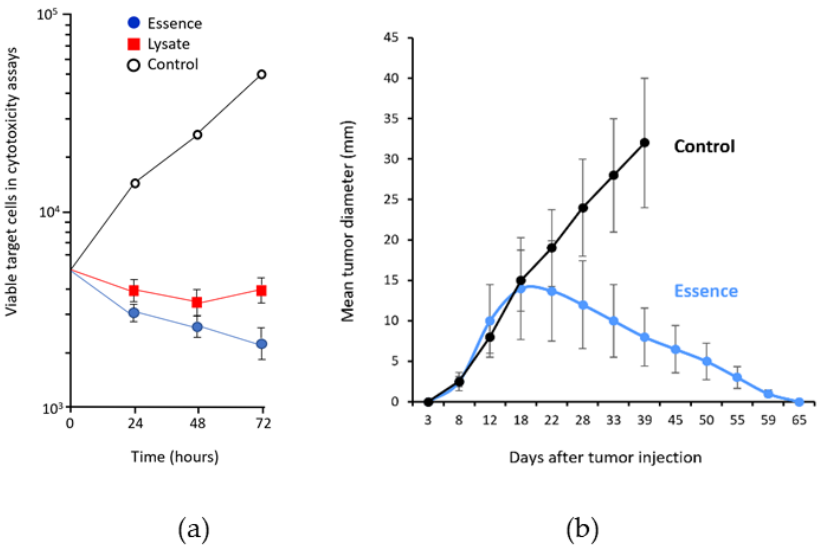
Figure 3. Antigenic equivalence of antigenic essence to whole cell lysate. ( a ) Cytotoxicity of effector cytotoxic T lymphocytes (CTLs) against human adenocarcinoma (MCF-7) cells. Target MCF- 7 cells were seeded in tissue culture plates, and then effector CTLs were added at CTLs:MCF-7 ratio 4:1. (●) MCF-7 cells incubated with CTLs that had been stimulated with antigenic essence-loaded dendritic cells (DCs). ( ■ )MCF-7 cells incubated with CTLs that had been stimulated with lysate-loaded DCs. ( ○ ) MCF-7 cells grown with unstimulated CTLs. Points represent the mean value of three identical measurements. Essence induces 10–40% more cytotoxic activity in CTLs than whole cell lysate, even though the total protein concentration of essence formulation was substantially lower (whole cell lysate: 270 μg/mL vs. essence: 2 μg/mL). Adapted from [30]. ( b ) Growth of hepatoma H22 on BALB/c mice in the experimental group vaccinated with the essence of H22 cells as compared to unvaccinated controls (mean ± SD). Adapted from [32].